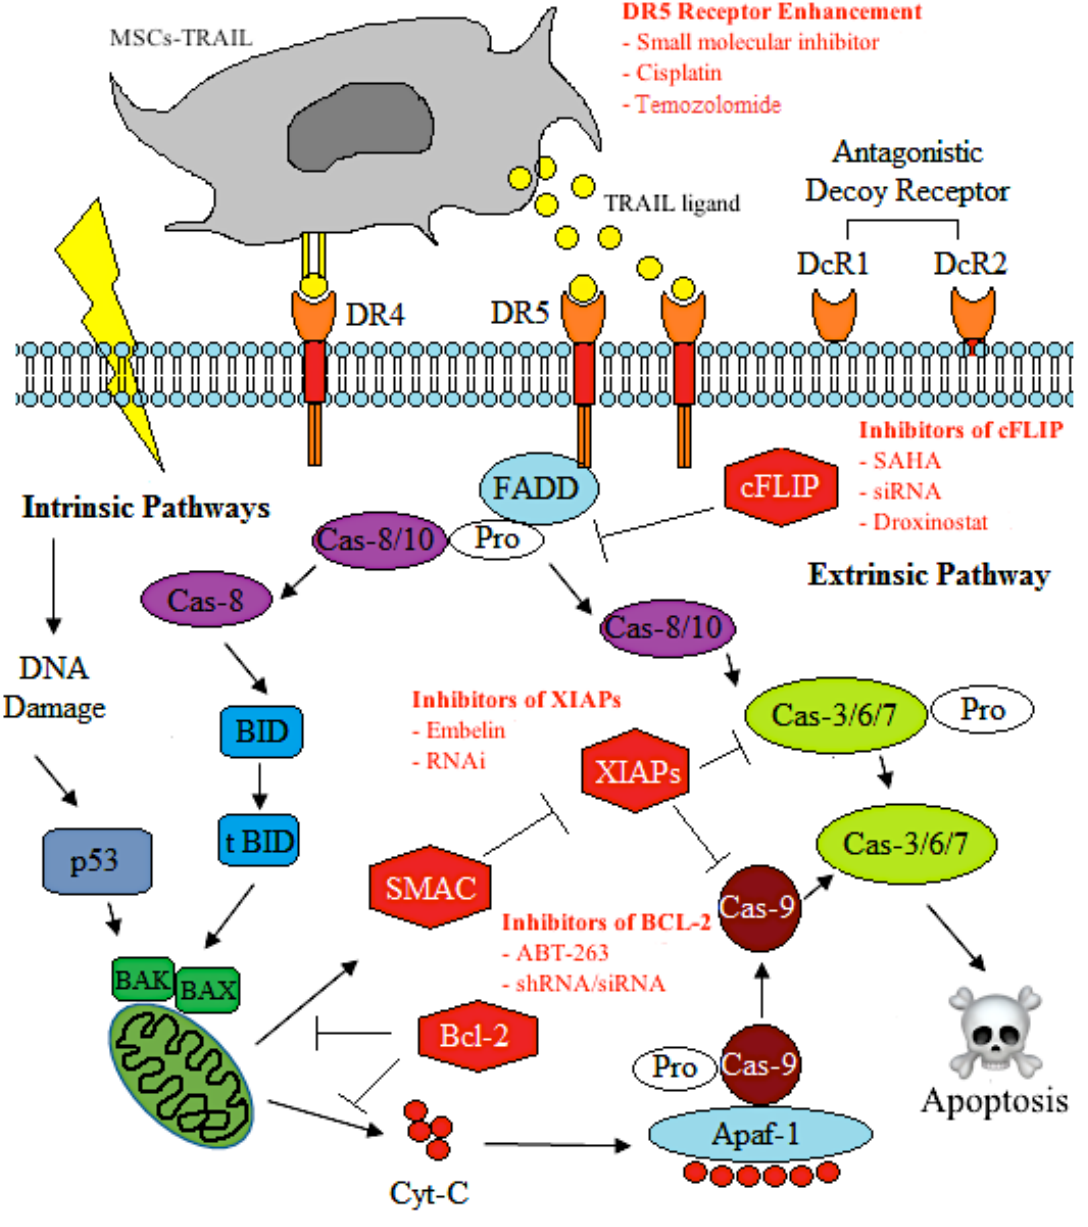
Figure 2. Sensitisation of tumour or cancer stem cells (CSC) to MSC-TRAIL induced apoptosis. An increase in the anti-apoptotic molecules (e.g., X-linked inhibitor of apoptosis proteins [XIAPs], cellular FLICE-like inhibitory protein [cFLIP], and B-cell lymphoma 2 [BCL-2]) upon TRAIL activation can be circumvented using specific inhibitors, as illustrated above. Through tumour sensitisation by anti-apoptosis gene silencing or specific DR5 receptor enhancement, and the utilization of MSCs as a vehicle for TRAIL delivery, a better treatment outcome could be